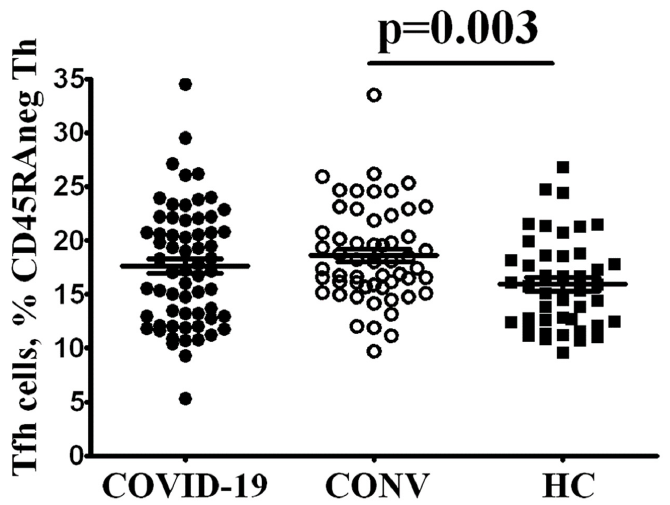
Figure 1. Evaluated level of circulating memory Tfh cells in COVID-19 convalescent patients.Scatter plots showing the percentages of CXCR5-expressing Th cell among total CD3+CD4+CD45RA − memory Th cells in the peripheral blood samples from patients with acute COVID-19 (COVID-19, black circles, n = 64), COVID-19 convalescent patients (CONV, white circles, n = 55) and healthy control (HC, black square, n = 44). Each dot represents individual subjects. and horizontal bars depict the group mean and standard error of the mean (Mean ± SEM). Statistical analysis was performed with the Mann-Whitney U test.